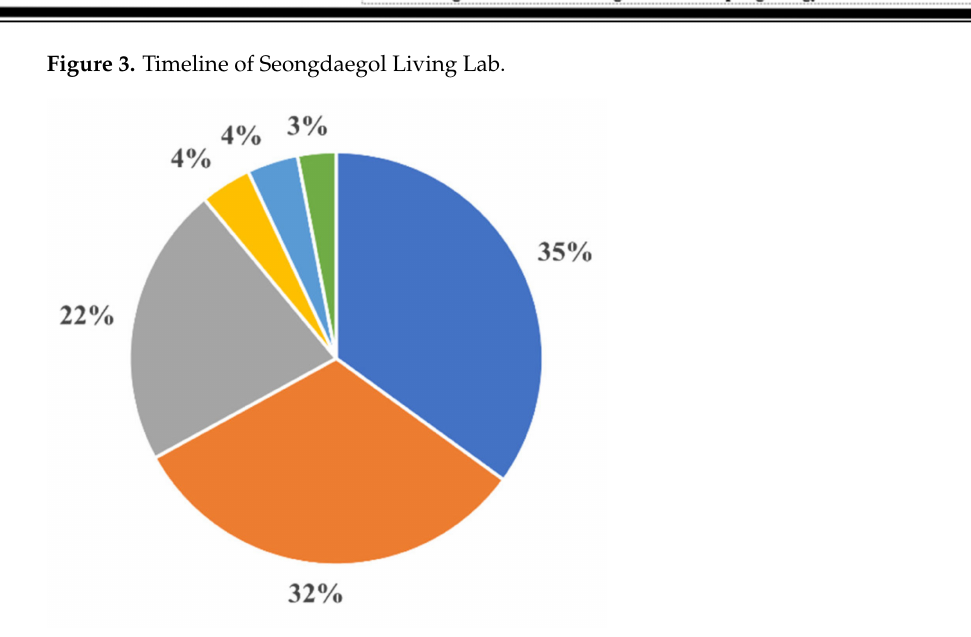
Figure 4. The ratio of SLL’s activities (2010–2020). (Source: Author reproduced from SLL white paper